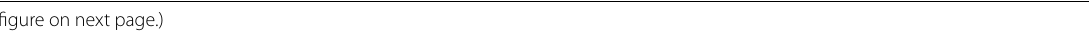
figure on next Fig. 2 Single cambial variant or combination of two cambial variants of stem cross section. A Interxylary phloem (enlargement): Thunbergia grandiflora . B Intraxylary phloem (enlargement) combined with successive cambia: Distimake tuberosus . C Irregular conformation combined with axial vascular elements in segments: Tetrastigma obtectum var. glabrum. D External primary vascular cylinders combined with axial vascular elements in segments: Piper kadsura . E Furrowed xylem of cambium continuity combined with intraxylary phloem: Gymnema sylvestre . F Furrowed xylem of cambium discontinuity combined with axial vascular elements in segments: Clematis gouriana subsp. lishanensis . PI, pith, TE, interxylary phloem, TR, intraxylary phloem, 1st XY, first xylem, 2nd XP, second xylem, 1st PH, first phloem, RA, ray, XY, xylem, PH, phloem, SCL, sclenchyma, MU, mucilage canal, ME, medullary vascular bundles, PE, peripheral vascular bundles, FD, furrowed xylem of cambium discontinuity, FC, furrowed xylem of cambium continuity, PW, phloem